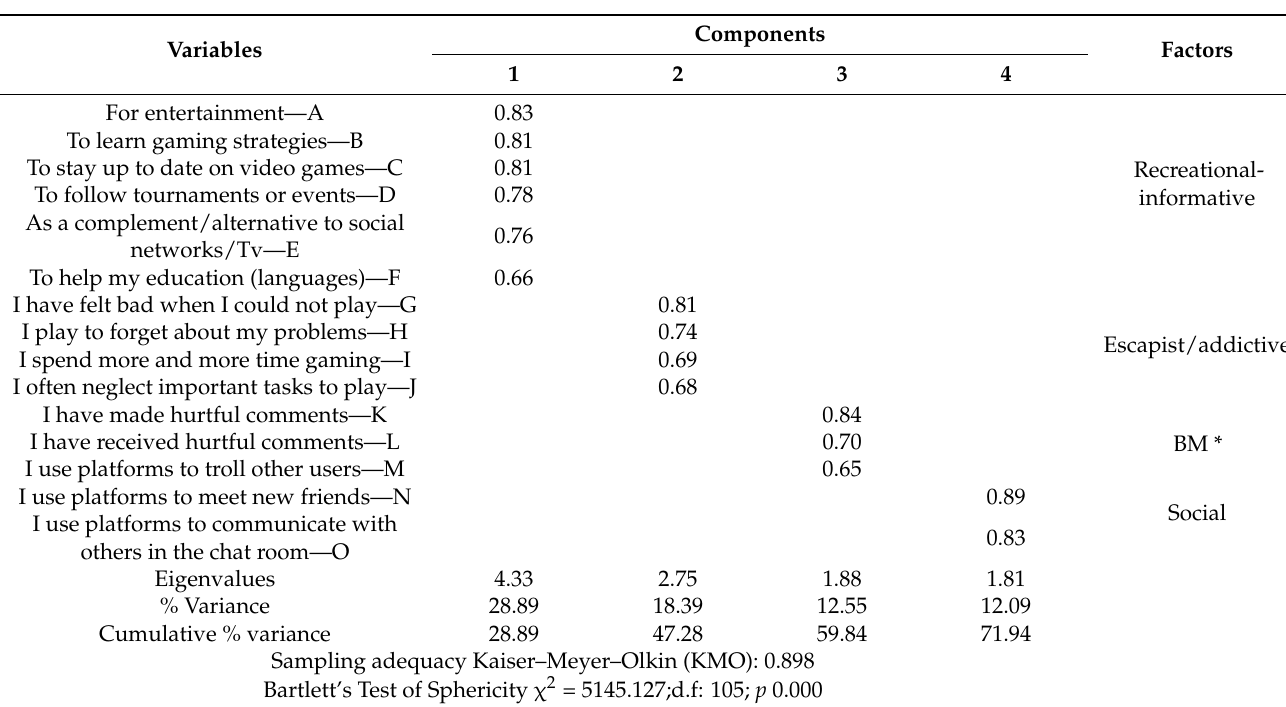
Table 2. Rotated component matrix. Gaming/viewing motivation variables.